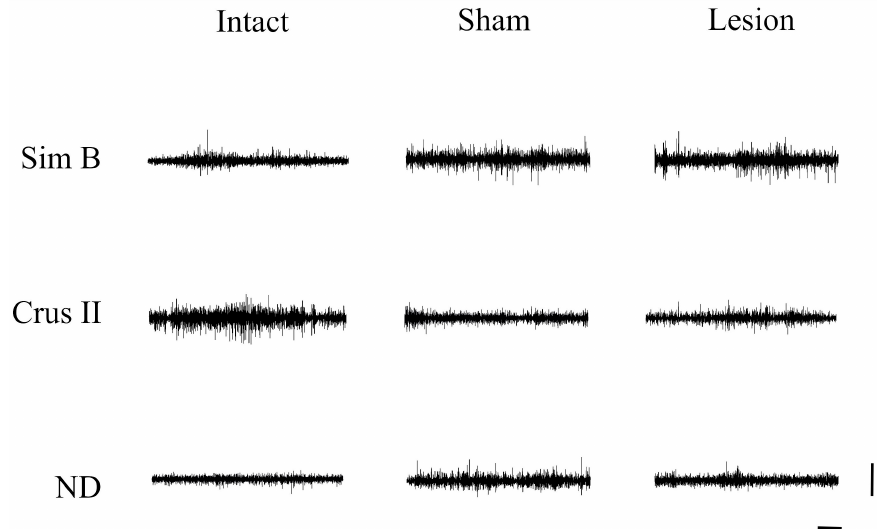
Figure 5. Representative traces of three-second multiunit activity were obtained during vertical exploration of animals from intact, sham, and lesion groups in the Sim B, Crus II lobes, and dentate nucleus. Horizontal calibration: 500 ms. Vertical Calibration: 2 mV.